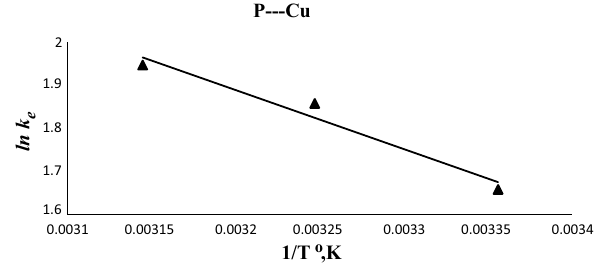
Fig. 4 Van’t Hoff plot for P–Cu adsorption system